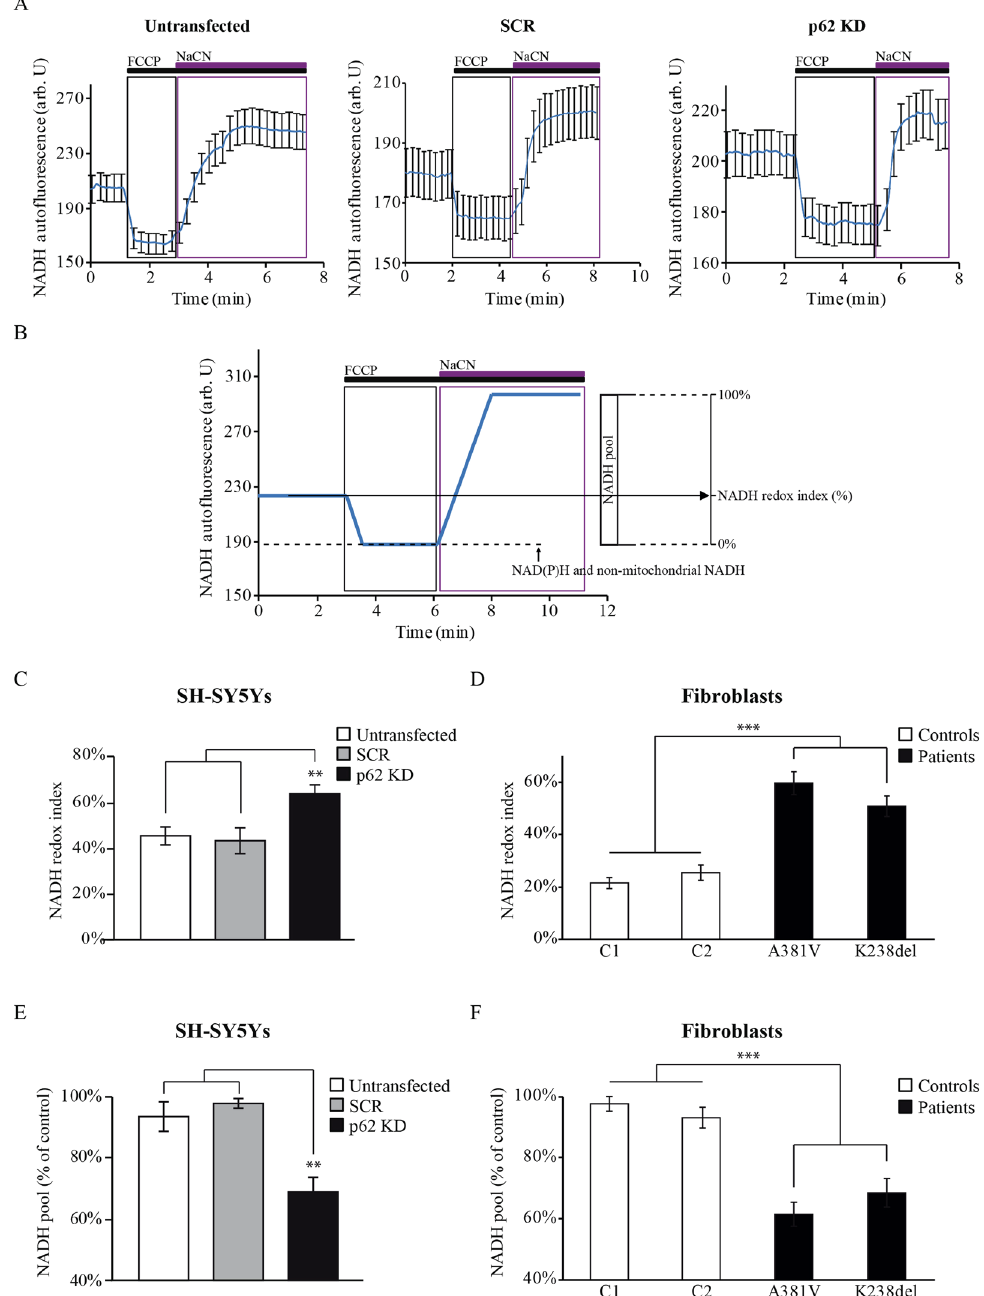
Figure 2. p62 deficiency disrupts the NADH homeostasis. ( A ) Time-course representative traces of NADH autofluorescence from untransfected, SCR and p62 KD in SH-SY5Y cells. The uncoupler FCCP (1 μ M) maximises mitochondrial respiration and therefore minimises mitochondrial NADH (0%). NaCN (1 mM) was then added to block mitochondrial respiration and thereby maximise mitochondrial NADH (100%). The traces represent the mean of at least 20 cells on a single coverslip ± SEM. ( B ) Graphical description of the NADH homeostasis analysis by monitoring the NADH autofluorescence in cells. NADH redox indexes were obtained by calculating the initial NADH autofluorescence when the minimum NADH autofluorescence is normalised to 0% and the maximum to 100%. Both the NADH redox index (the initial redox level expressed as percentage of the range) and the NADH pool are described graphically. ( C,D ) NADH redox indexes from untransfected, SCR and p62 KD SH-SY5Y cells ( C ) and control and p62 deficient fibroblasts ( D ) representing the mean of at least 3 independent experiments ± SEM. In all cases ** indicates p < 0.01 and *** indicates p < 0.001 compared with the values in control cells. ( E,F ) The NADH pool was expressed as absolute values between maximal and minimal respiration in untransfected, SCR and p62 KD SH-SY5Y cells ( E ) and control and p62 mutant fibroblasts ( F ). Data represent the mean of at least 3 independent experiments ± SEM. In all cases ** indicates p < 0.01 and *** indicates p < 0.001 compared with the values in control